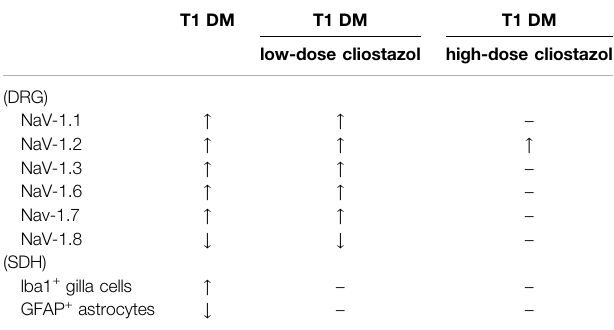
TABLE 1 | Summary of the differential responses of NaV proteins in dorsal root ganglia neurons and microlglia cells in spinal dorsal horns toward cilostazol treatments in streptozotocin-induced type I diabetic rats.